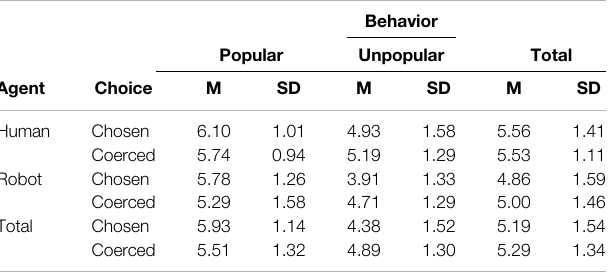
TABLE 2 | Means and standard deviations for impressions (1 – 7; Negative: Positive).